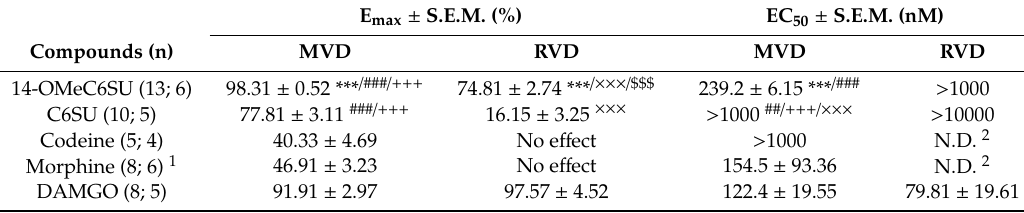
opioid agonists, morphine and